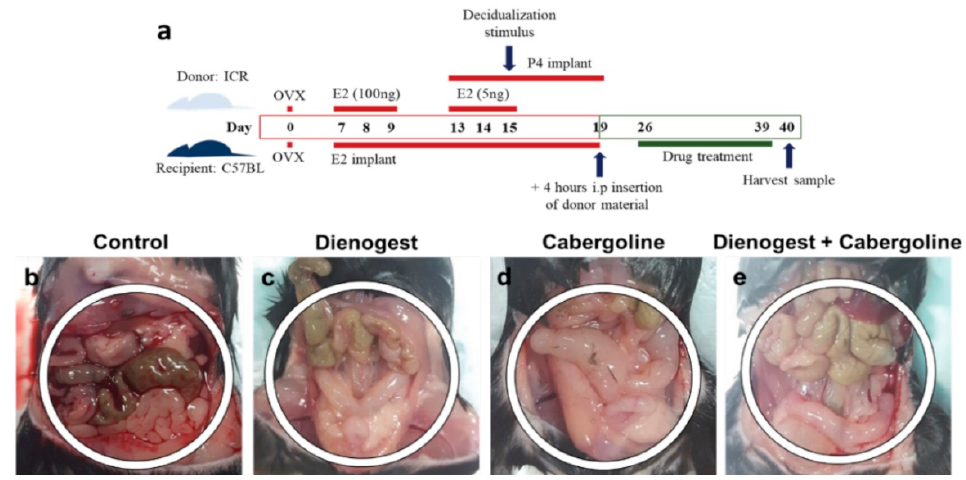
Figure 1. Schematics showing procedures for preparing for the endometriosis animal model. ( a ) Whole procedure for inducing endometriosis with OVX (ovariectomy), E2 (estradiol), and P4 (progesterone) treatment. ( b – e ) Image of the abdomen area during the anatomic procedure used to establish the endometriosis animal model; ( b ) Control, ( c ) Dienogest, ( d ) Cabergoline, and ( e ) combined treatment.